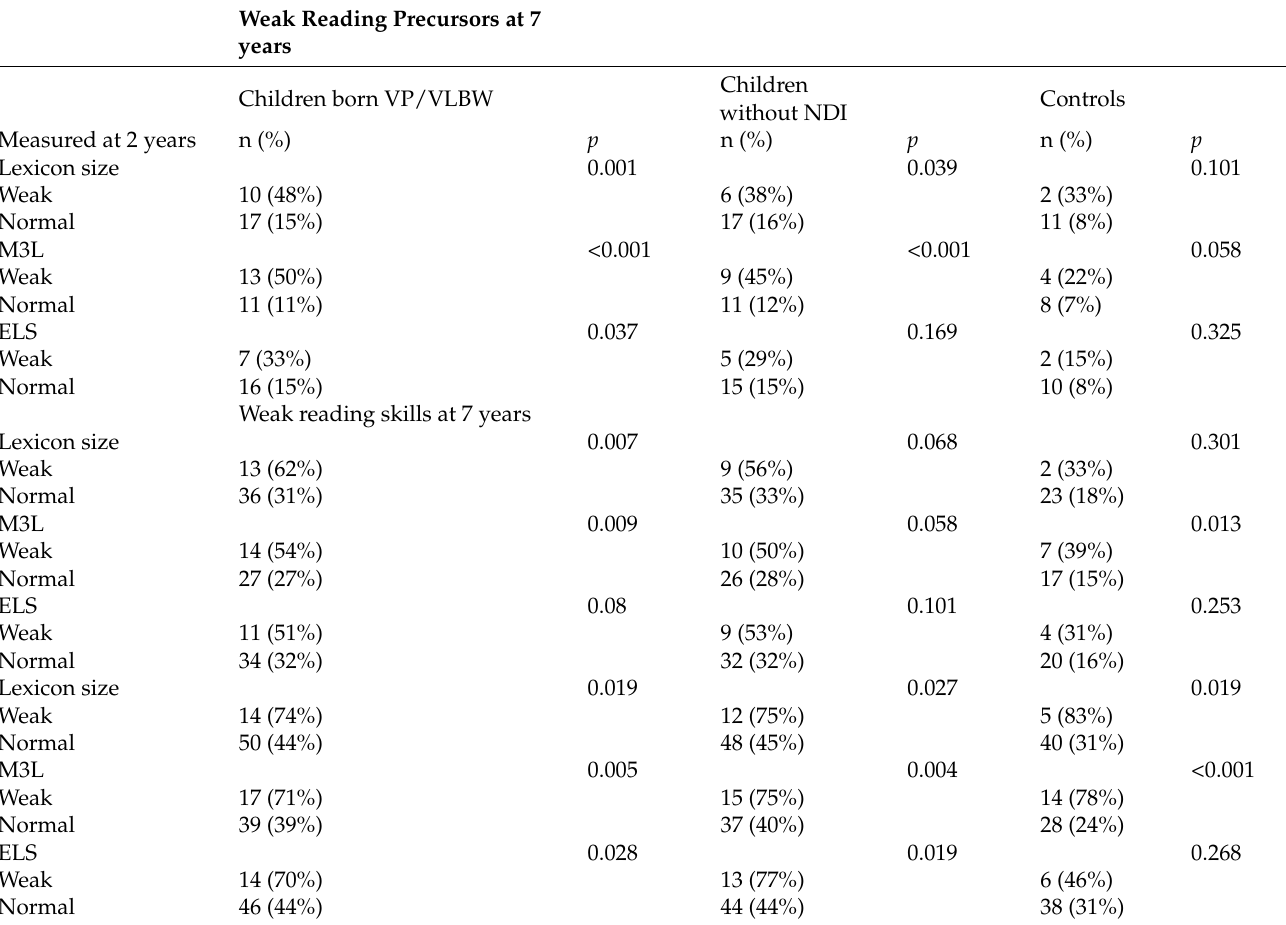
Table 4. Results of the cross-tabulation with Chi-square or Fisher’s exact tests of the associations between weak lexicon size (10th percentile, <30 words), weak M3L (10th percentile, <2.06), weak ELS (10th percentile, <1.60) measured at 2 years, and weak reading precursors (10th percentile, <25), weak reading (<10th percentile, 0 words), and weak writing (10th percentile, 0 words) measured at 7 years. Results for all VP/VLBW children, for VP/VLBW children without NDI, and for full-term controls are